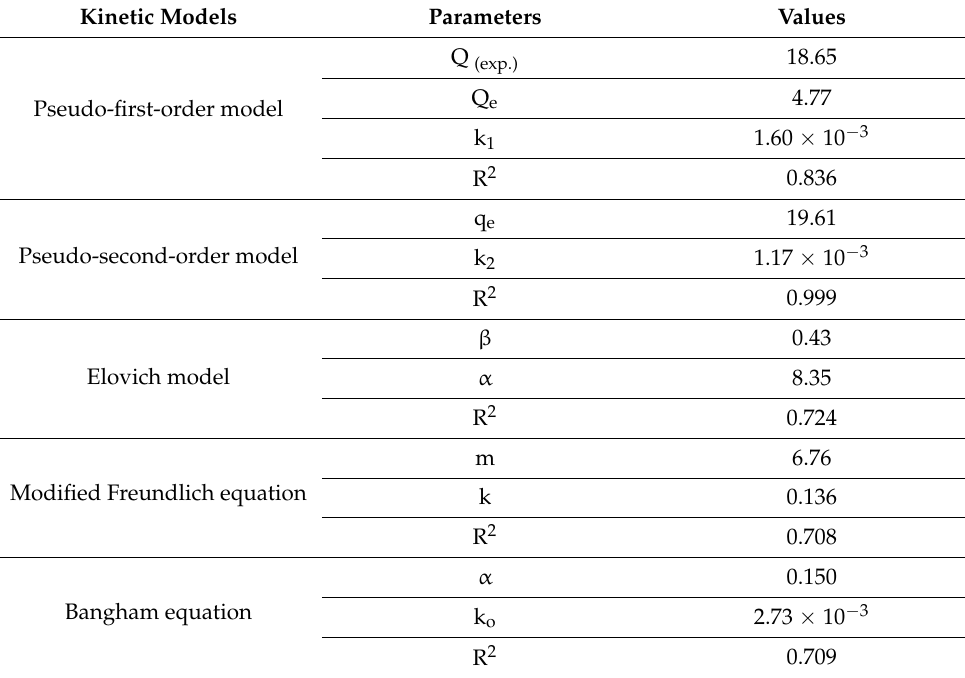
Figure 6. ( a ) Bangham model, ( b ) the plot of 1/T vs. lnK c for adsorption of MO onto the DMEA-grafted AEM.